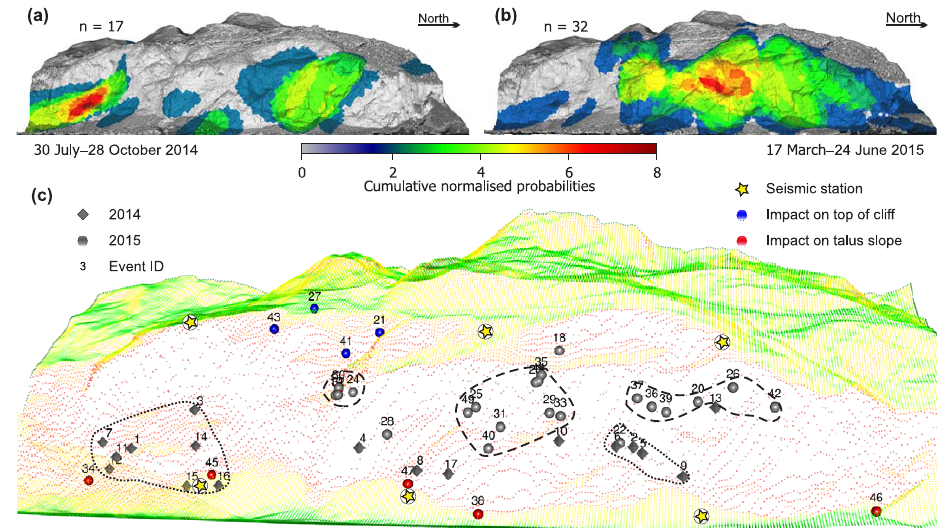
Figure 5. Spatial rockfall activity patterns. (a) 3-D scene view of compound seismic location estimates for summer–autumn 2014. (b) 3-D scene view of compound seismic location estimates for spring 2015. Normalised probabilities are based on summation of normalised location probabilities > 97% for all detected events. (c) 3-D point cloud view of DEM pixels coloured by normalised slope inclination (note the sparse coverage of the steep cliff parts) and maximum location probability of rockfall events as numbered spheres. Blue spheres indicate events at or directly below the cliff edge, red spheres denote events with impact locations at the talus slopes and black spheres denote events in the central cliff part. Cube symbols depict 2014 events, and sphere symbols denote 2015 events. Dotted lines encircle 2014 activity hotspots, and dashed lines show 2015